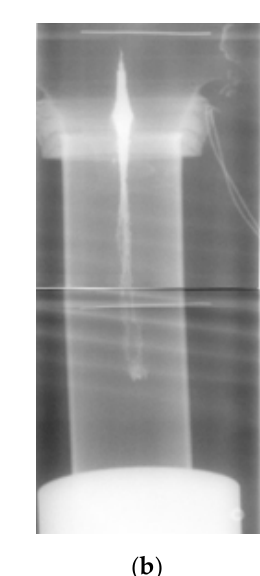
Figure 8. X-ray image of the Zr-based amorphous alloy jet (S3): ( a ) captured by the light outlet A at 31.082 μs and ( b ) captured by the light outlet B at 40.701 μs. For the shaped charge numbered H4, the actual light-emitting time of channel A was 32.748 μs; at the time, the lengths of the jet’s head and slug were 117.44 and 58.13 mm, respectively. The actual light-emitting time of channel B was 40.802 μs, and at the time, their lengths were 181.85 and 55.9 mm. Figure 9 shows the X-ray images of the jet captured by the light outlets A and B. After equivalent conversion, the velocity of the jet’s head was obtained to be 7116 m/s.